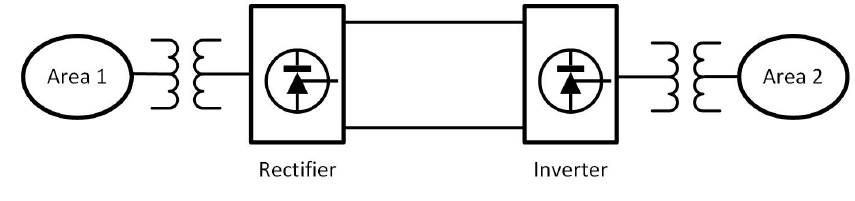
Figure 1. Overview of a two-terminal line commutated converter (LCC)-HVDC